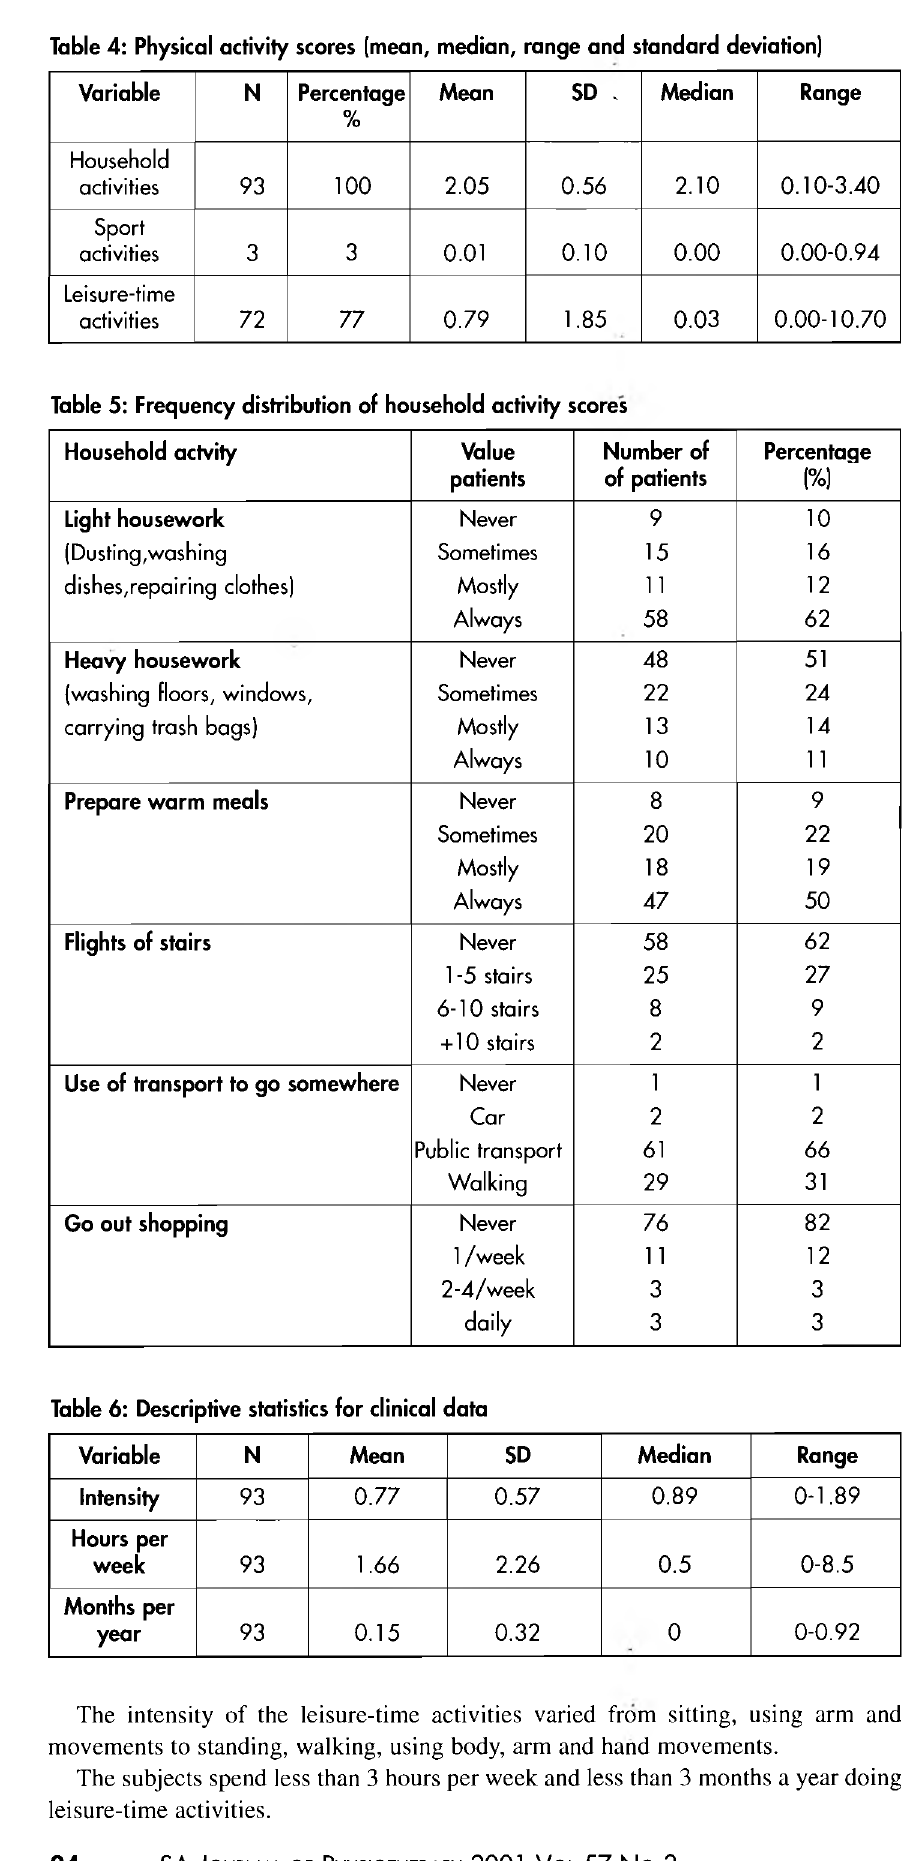
Table 4: Physical activity scores (mean, median, range and standard deviation)